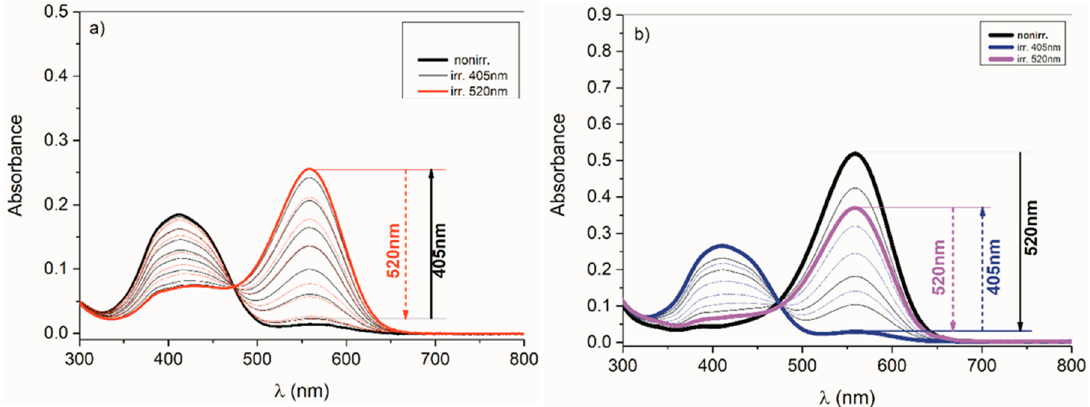
Figure 5. Reversible phototautomerization of hydrazone 3 (1 × 10 − 5 mol·dm − 3 ) in DMF: ( a ) Z -isomer; ( b ) E -isomer.